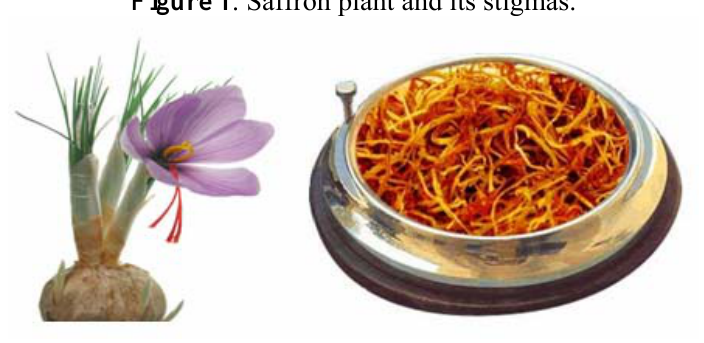
Figure 1 . Saffron plant and its